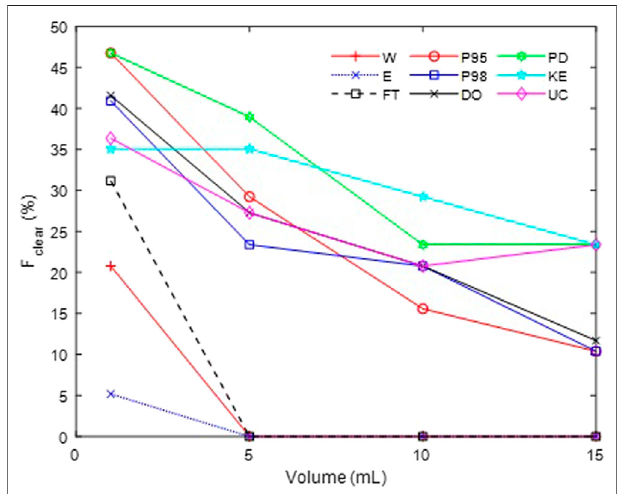
FIGURE3| Graphplotforclearareapercentageagainstvolumeforeach sample liquid.